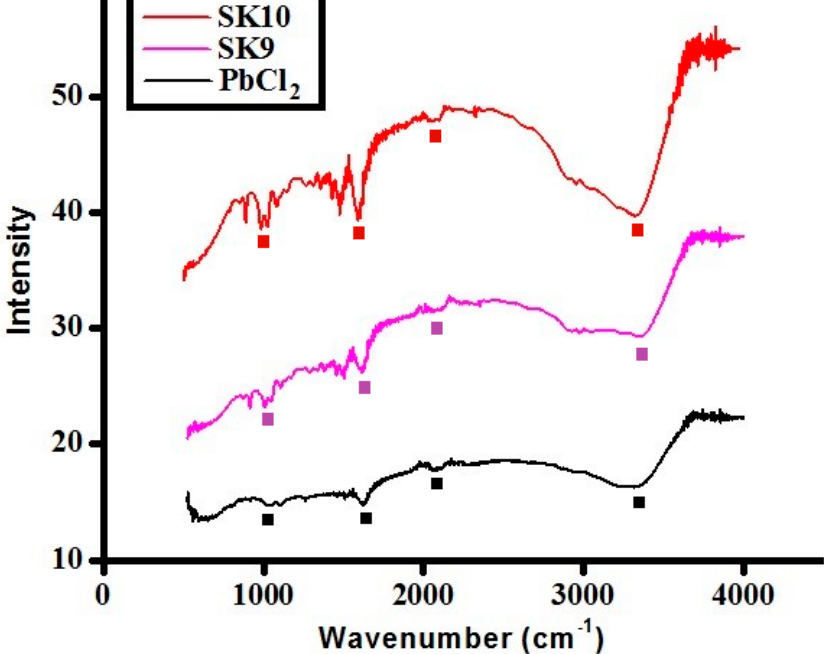
Figure 6. IR spectra of synthesized perovskites ( SK9 – SK10 ).